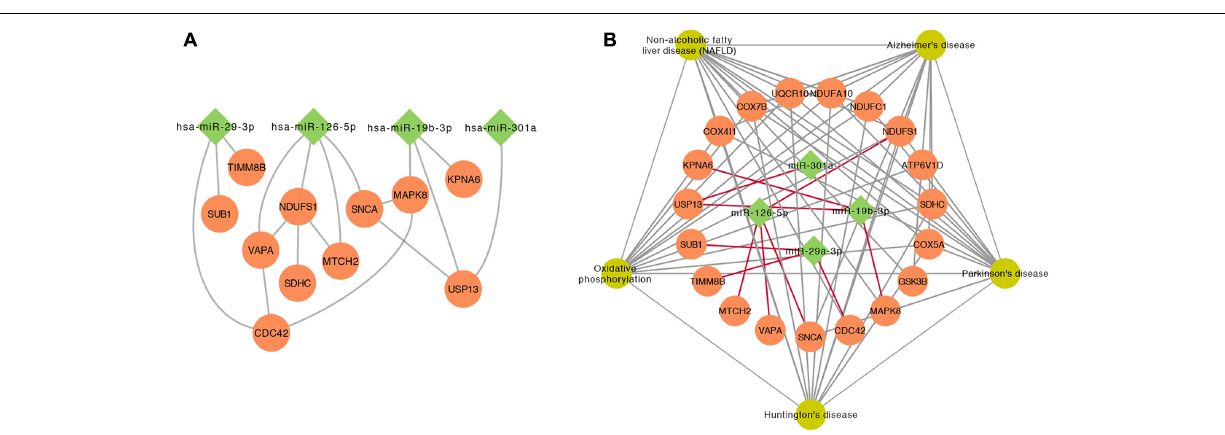
dehydrogenase (also known as mitochondrial complex II) is a key enzyme complex of the tricarboxylic acid cycle and aerobic respiratory chains of mitochondria, which shows that the relationship between SDHC and PD deserves further